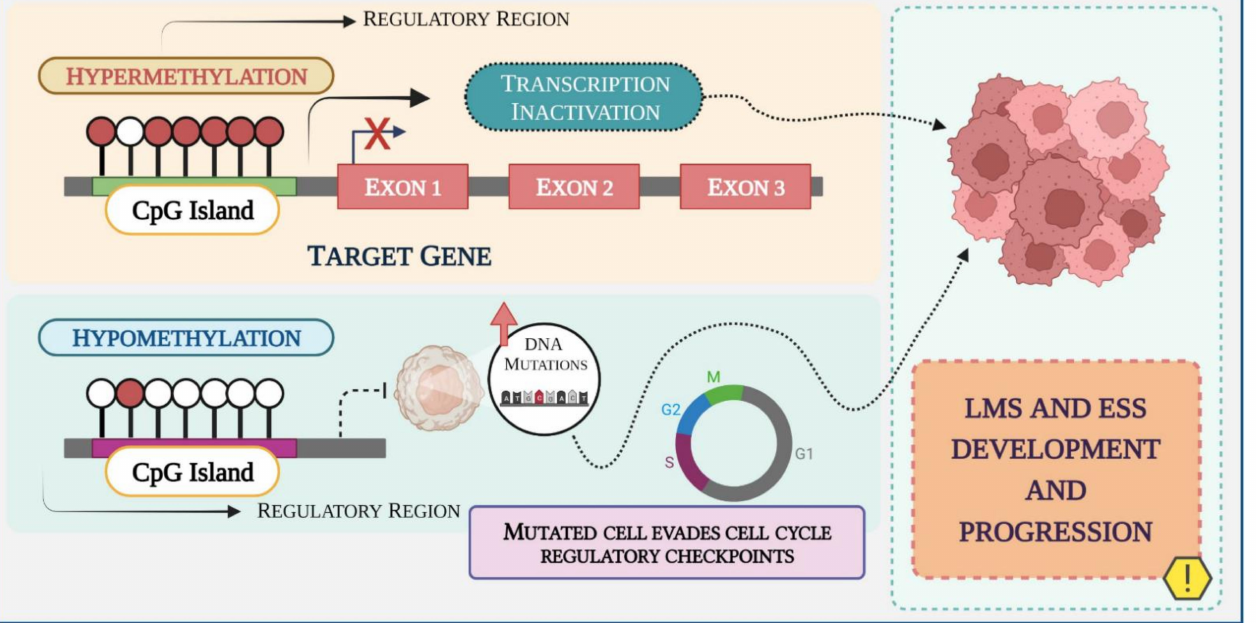
Figure 3. Schematic representation of the DNA methylation process in LMS and ESS during cancer development and progression. Methyl groups are added to the DNA molecule and change its activity. Promoter hypermethylation has been shown to silence tumor suppressor genes in cancer cells, leading to either dysregulation of cell growth or inducing resistance to cancer therapies. Hypomethylation promotes genomic instability causing missegregation of chromosomes during cell division. Created with